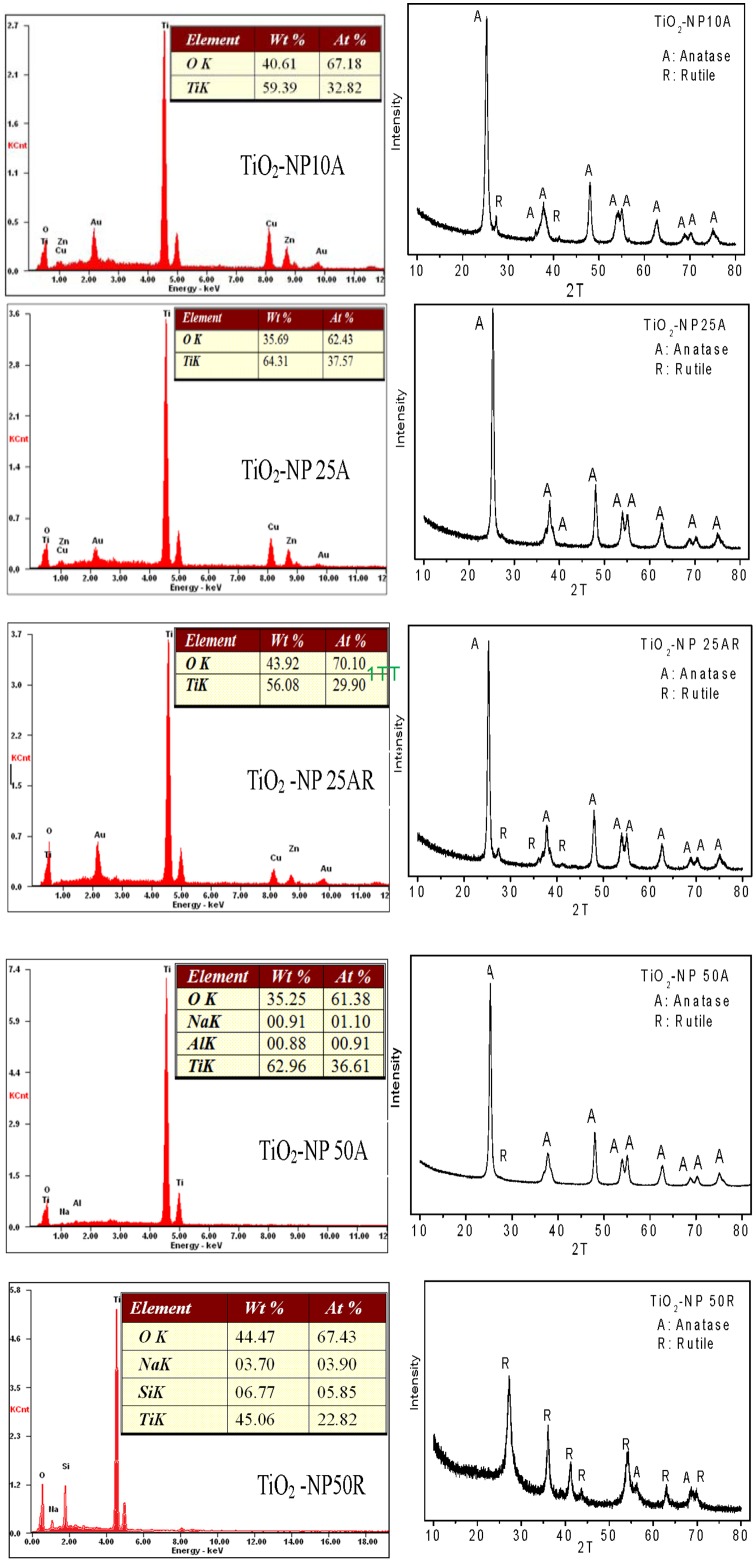
EDS (left column) and XRD (right column) figures of the as-received TiO2 NPs.